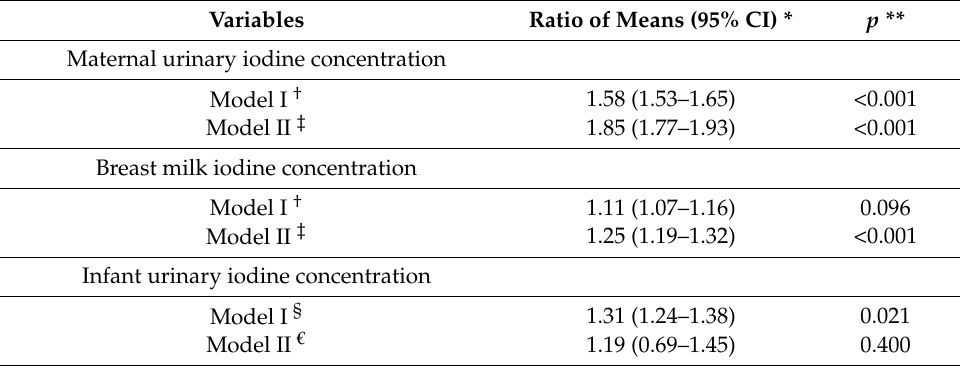
Table 3. Effects of iodine fortified milk on maternal and infant urinary and breast milk iodine concentrations.